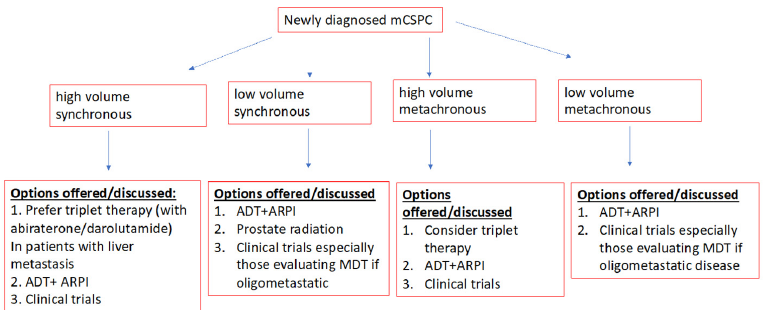
Figure 1. Proposed patient selection algorithm for patients with mCSPC. CSPC—castrate sensitive prostate cancer, ADT—androgen deprivation therapy, ARPI—androgen receptor axis targeted therapy, MDT—metastasis directed therapy.